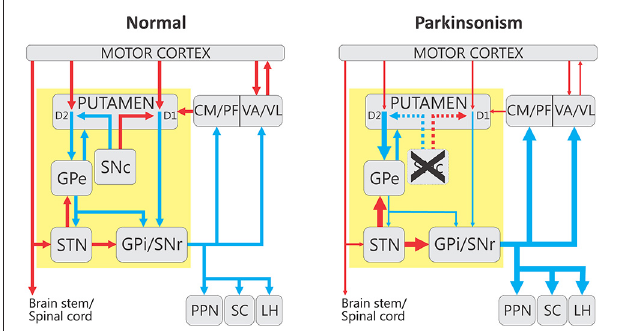
FIGURE 1 | Firing rate changes in the basal ganglia-thalamo-cortical motor circuit in parkinsonism . The yellow box indicates the interconnected basal ganglia nuclei that receive extrinsic input from the cortical and thalamic regions. For simplicity some connections have been omitted from this diagram. The left panel indicates the circuits in the “Normal” state, and the right shows the overall changes in activity that have been associated with parkinsonism. Blue and red arrows indicate inhibitory and excitatory connections, respectively. The thickness of the arrows corresponds to their presumed activity. Abbreviations: CM, centromedian nucleus of thalamus; D1 and D2, dopamine receptor subtypes; GPe, external segment of the globus pallidus; GPi, internal segment of the globus pallidus; LH, lateral habenula; PF, parafascicular nucleus of the thalamus; PPN, pedunculopontine nucleus; SC, superior colliculus; SNc, substantia nigra pars compacta; SNr, substantia nigra pars reticulata; STN, subthalamic nucleus; VA, ventral anterior nucleus of thalamus; VL, ventrolateral nucleus of thalamus.